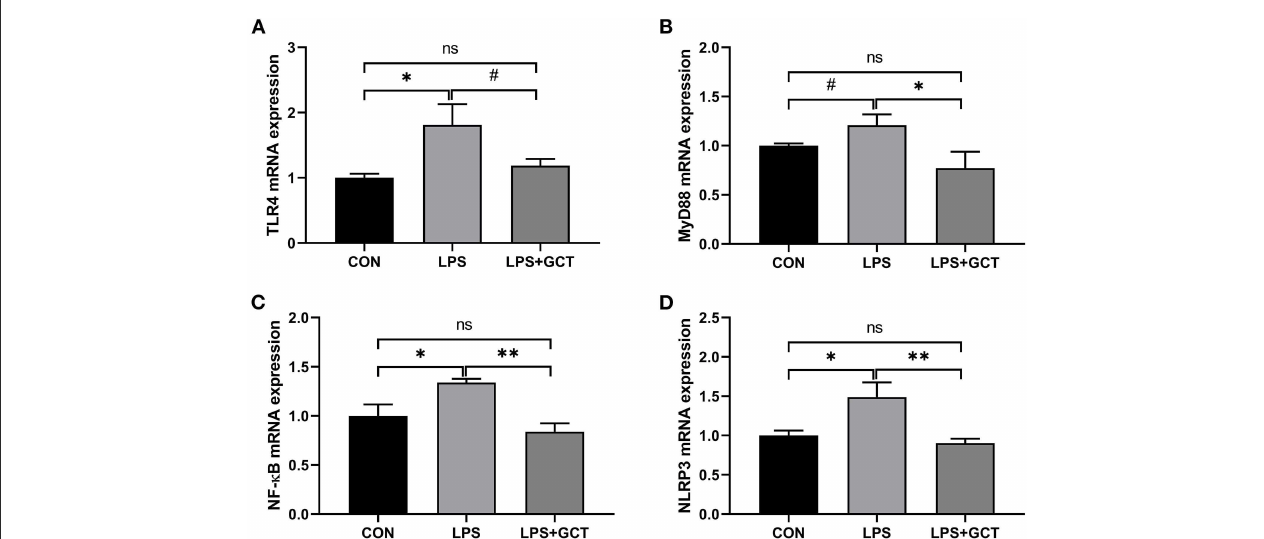
FIGURE7 Effects of dietary Galla Chinensis tannin (GCT) supplementation on expressions of inflammatory pathway genes in liver of broilers under lipopolysaccharide (LPS)-challenge. (A) Toll-like Receptor 4 ( TLR4 ); (B) Myeloid differentiation primary response 88 ( MyD88 ); (C) Nuclear factor-kappa B ( NF- κ B ); (D) NLRs family pyrin domain containing 3 ( NLRP3 ). CON, fed on a basal diet and intraperitoneally injected with saline solution; LPS, fed on a basal diet and intraperitoneally injected with LPS; LPS + GCT, fed on a basal diet supplemented with 300 mg/kg GCT and intraperitoneally injected with LPS. Values are presented as mean ± standard error ( n = 6). * p < 0.05, ** p < 0.01, # 0.05 < p < 0.10; ns, non-significant.